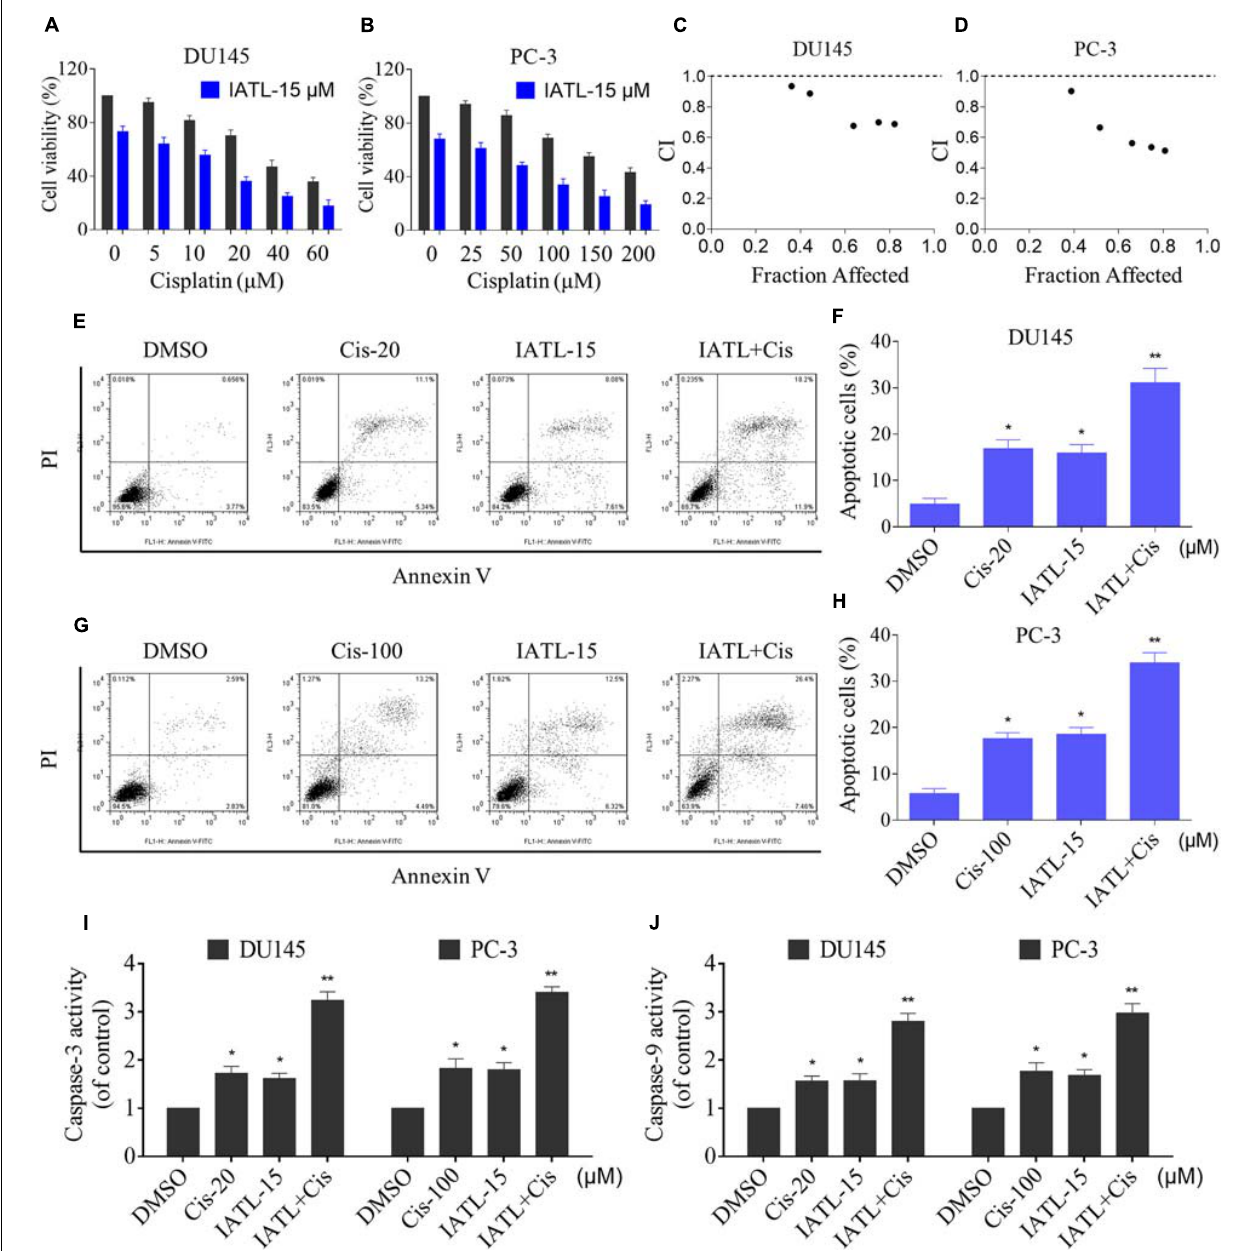
FIGURE 1 | IATL and cisplatin synergistically inhibit cells growth and induce apoptosis. (A,B) DU145 or PC-3 cells were treated with IATL or cisplatin alone or their combination at the indicated concentration for 24 h; cell viability was determined by an MTT assay. (C,D) Combination index (CI) values were calculated by the Calcusyn software, and a CI value of less than 1 indicates synergism. (E–H) DU145 or PC-3 cells were treated with IATL or cisplatin alone or their combination at the indicated concentration for 24 h; cell apoptosis rate was analyzed by flow cytometry. (I,J) DU145 or PC-3 cells were treated with IATL or cisplatin alone or their combination at the indicated concentration for 20 h; caspase-3 and caspase-9 activity were measured by an assay kit. * p < 0.05, ** p <